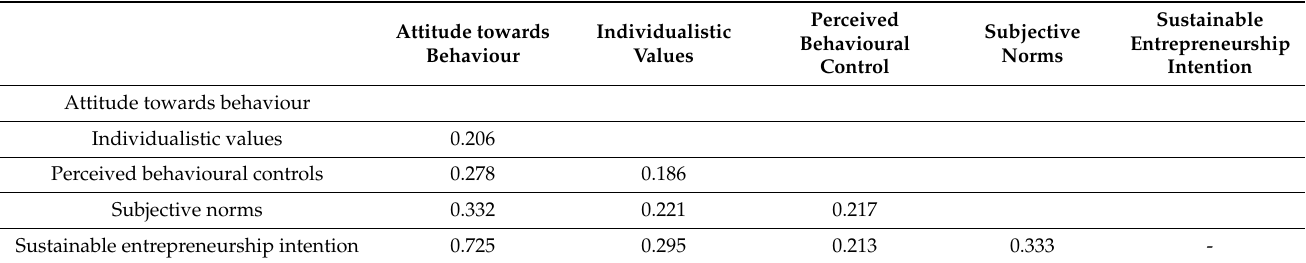
Table 6. Heterotrait–monotrait ratio of correlations (HTMT).